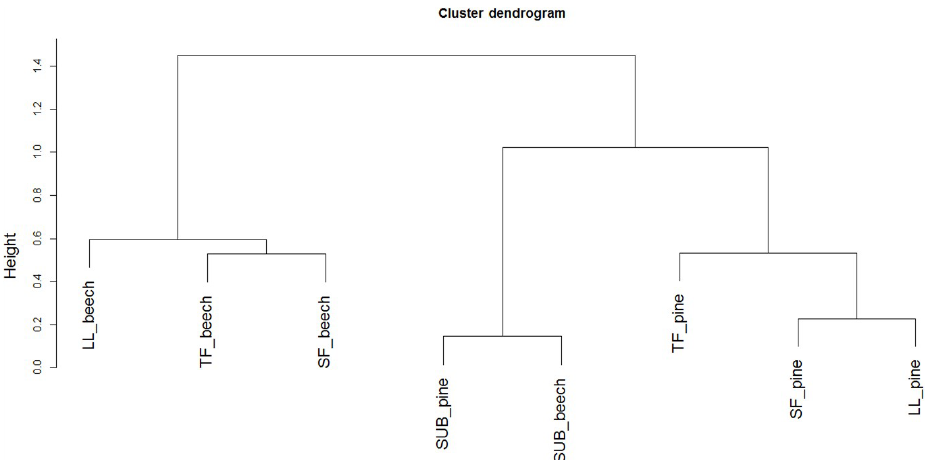
Figure 6. Cluster dendrogram of the number of molecules assigned to major groups of biomolecules (tannin-like, lignin-like, lipid-like, protein-like, amino-sugar-like, and hydrocarbon-like) according to Sleighter and Hatcher (2007) obtained from FTI-CR mass spectra of DOM samples from ecosystem fluxes of coniferous (pine) and unmanaged beech forest from Schorfheide sites. TF: throughfall; SF: stemflow; LL: litter leachate; SUB: subsoil